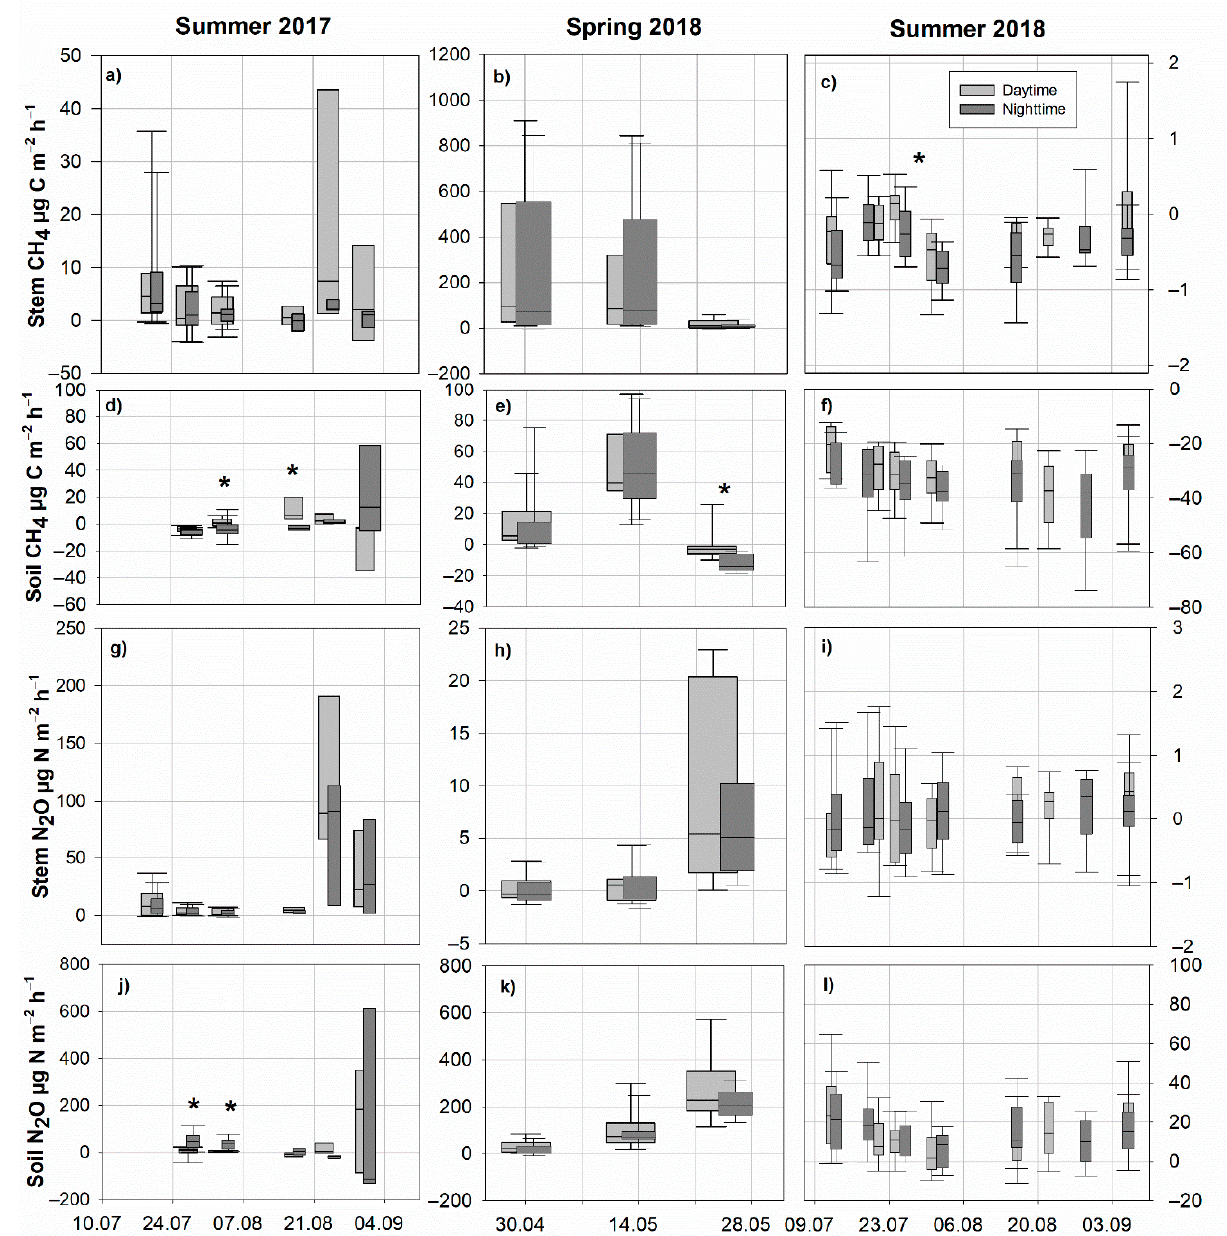
Figure 2. Stem CH 4 -C ( a – c ) and N 2 O-N ( g – i ) fluxes and soil fluxes of CH 4 -C ( d – f ) and N 2 O-N ( j – l ) during the three studied periods, each at daytime (12:00–16:00) and nighttime (0:00–04:00). Fluxes are expressed per m 2 of stem or soil surface area. Please note different flux scales. Asterisks mark the statistically significant differences ( p < 0.05) in fluxes between day- and nighttime Positive fluxes indicate gas emission, while the negative fluxes indicate gas uptake.